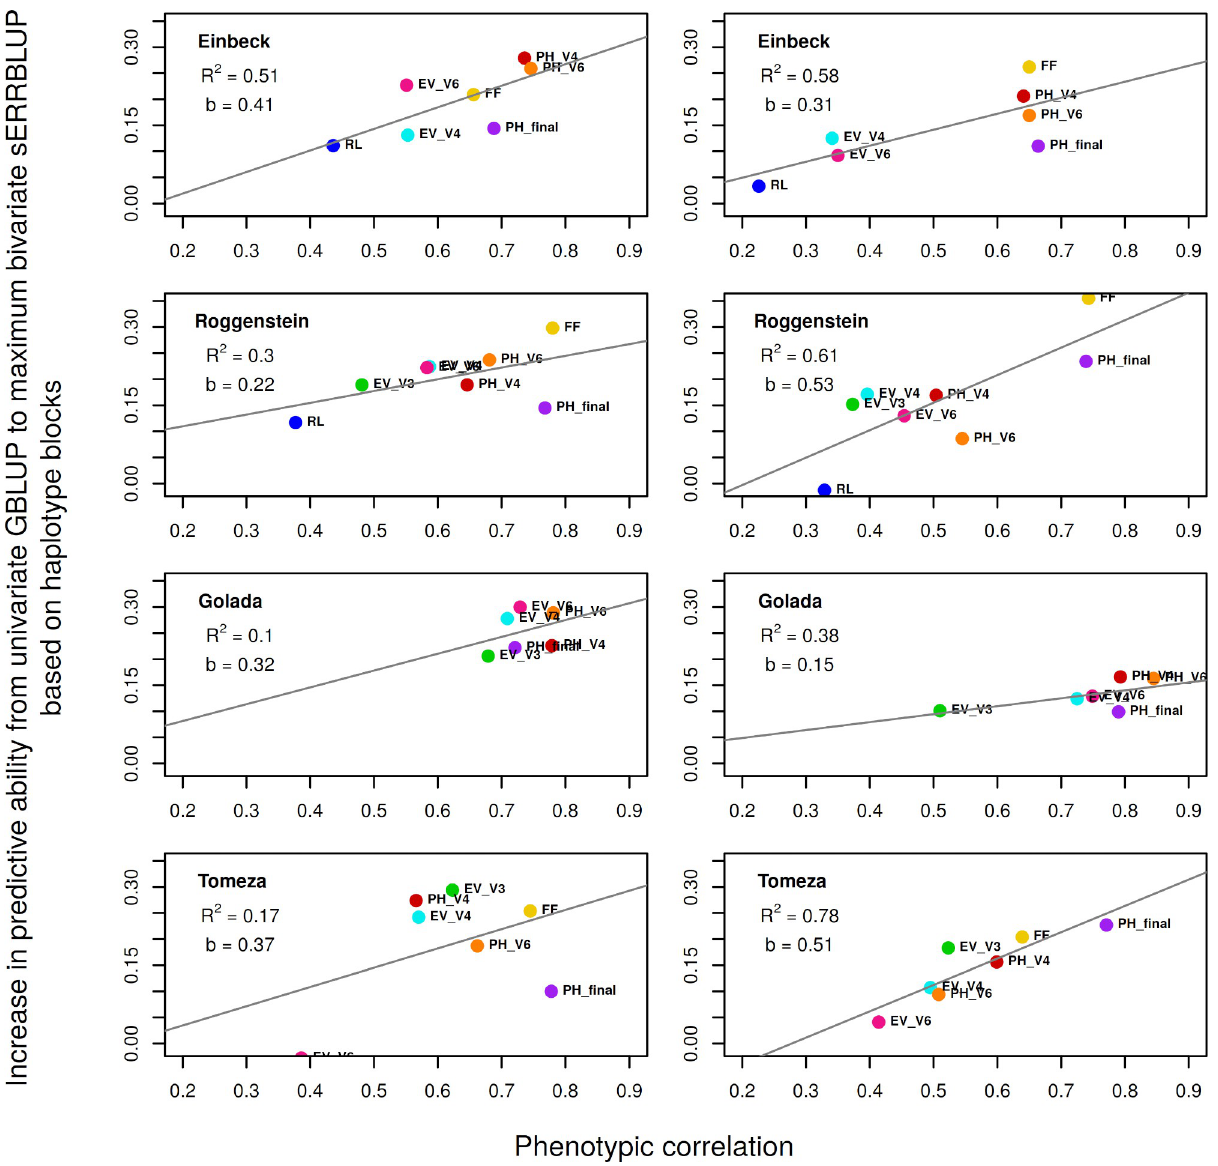
Fig 4. Regression of the absolute increase in predictive ability from univariate GBLUP to maximum bivariate sERRBLUP on the phenotypic correlation between 2017 and 2018 in Kemater (left) and in Petkuser (right) for all studied traits. In each panel, the overall linear regression line (gray solid line) with the regression coefficient ( b ) and R-squared ( R 2 ) are